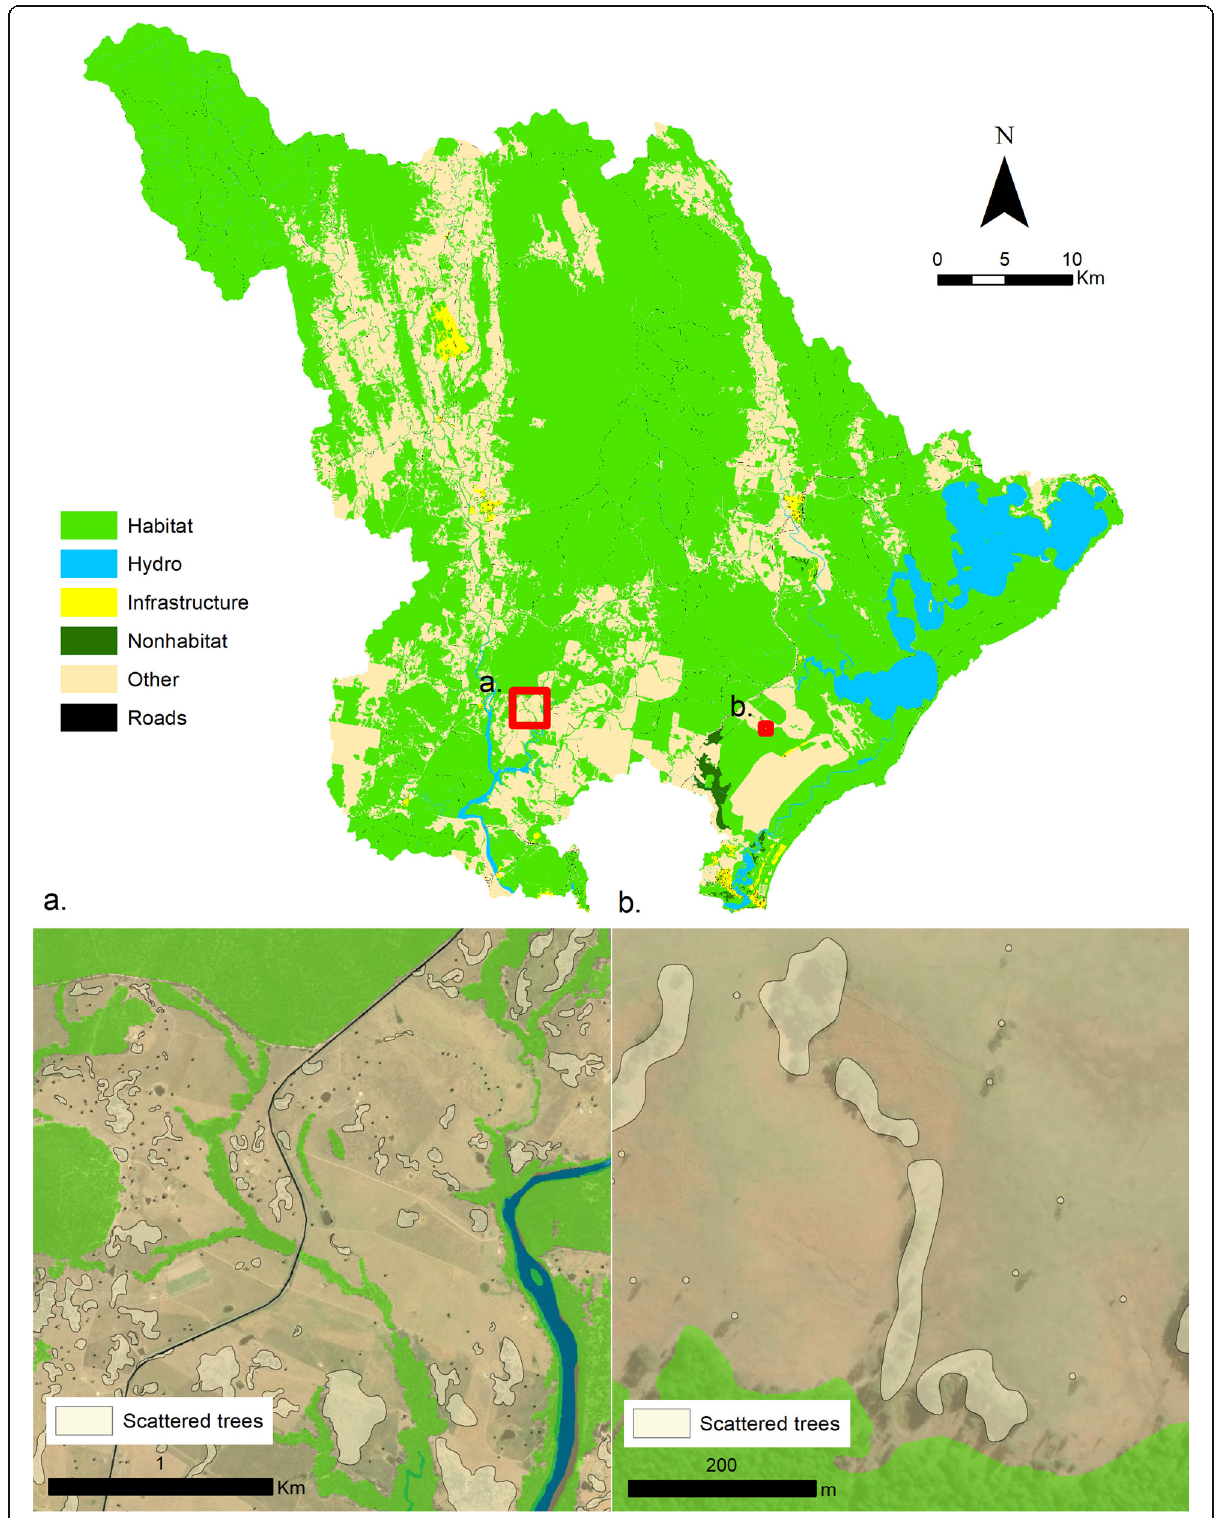
Fig. 2 Land cover map depicting general land cover classes (Table 1) and scattered trees. Individual scattered trees are shown as points and grouped scattered trees as polygons in insets a ,